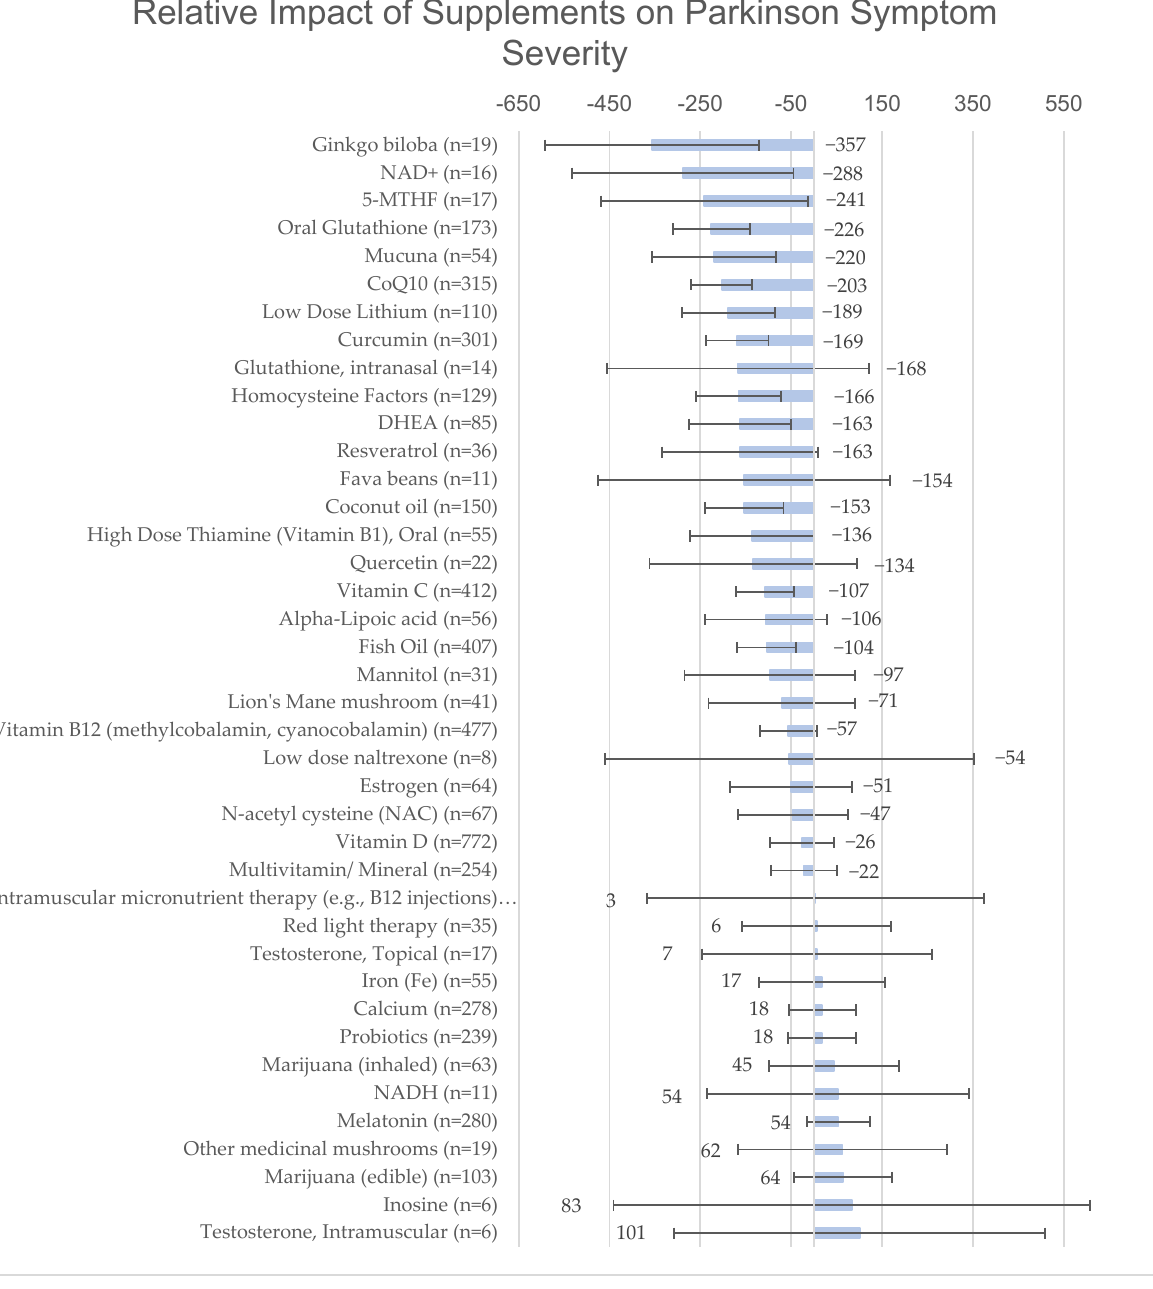
Figure 2. Relative impact on PRO-PD scores with 95% confidence intervals by linear regression adjusted for age, gender, income and years since diagnosis. Supplements not significantly associated with a statistically significant difference in outcomes included: alpha-lipoic acid ( β = − 106, CI95%: − 240–28.5; p = 0.1),